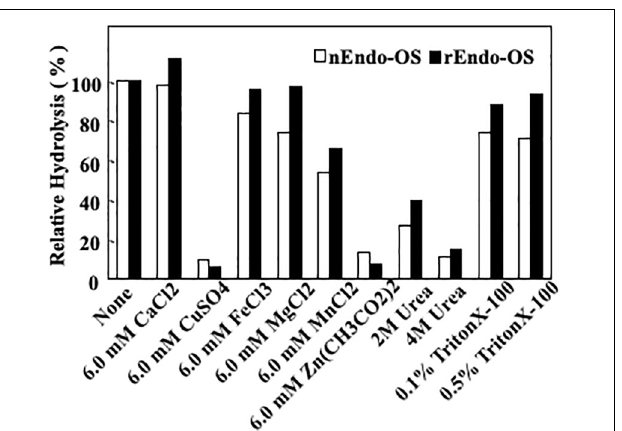
FIGURE 4 | Purification of recombinant Endo- β -GlcNAc-ase. (A) Proteins were separated using SDS-PAGE on a 7.5% acrylamide gel under reduced conditions using 1 mM DTT. Proteins on the gel were stained with Coomassie Brilliant Blue R-250; (B) Assay of endo- β -GlcNAc-ase activity on RP-HPLC. I, Control; II, Enzyme digestion.